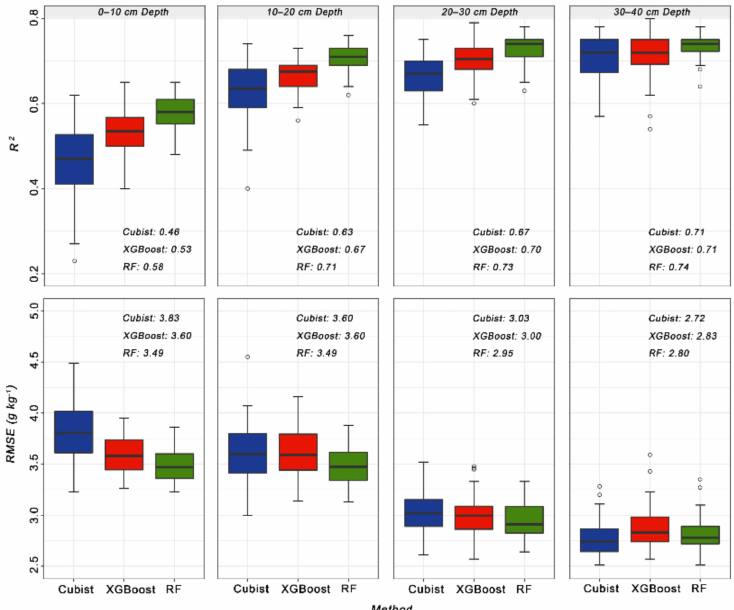
Figure 3. Boxplots of Cubist, XGBoost and RF on the prediction of SOC concentration, assessed by R 2 and RMSE of the independent validation dataset.